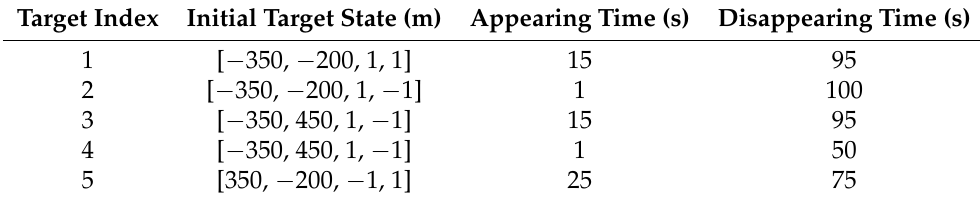
Figure 10. Target trajectories: ‘ + ’ represents locations of target birth; ‘ (cid:13) ’ represents locations of target death. Table 2. The detailed parameters of targets int the intersection